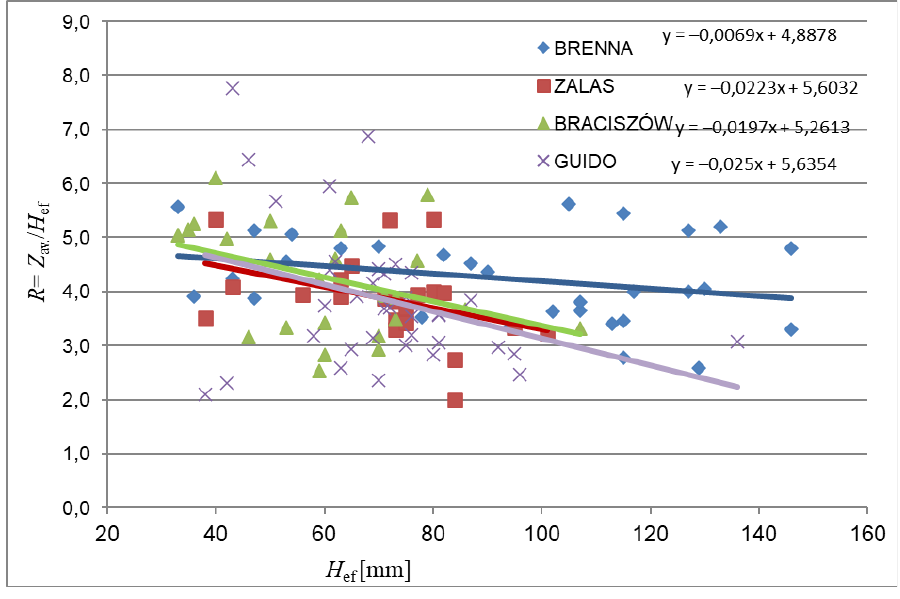
Figure 16: Changes in the coefficient R in relation to the effective anchoring depth H